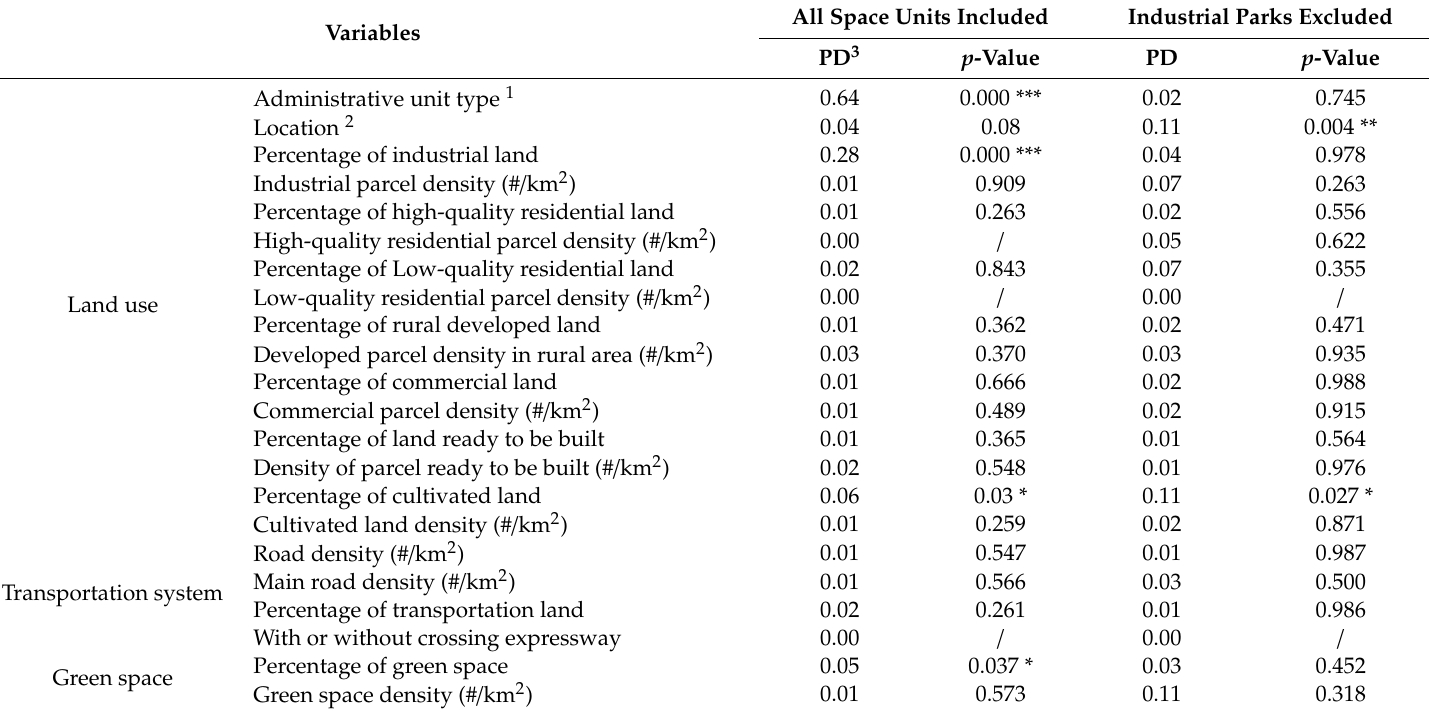
Table 2. Spatial association between built environment factors and lung cancer